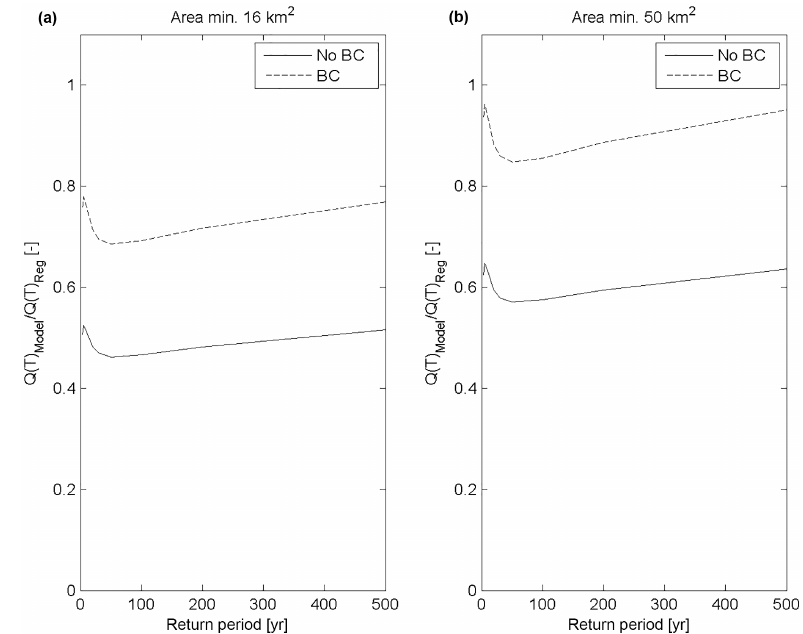
Figure 14. Mean Ratio( T ) over the considered domain as a function of T . The continuous line (no BC) is the case without rainfall bias correction, and the dotted line (BC) is the case with rainfall bias correction. (a) is the case where points with drainage area lower than 16km 2 are discarded; (b) is the case where points with drainage area lower than 50km 2 are discarded.